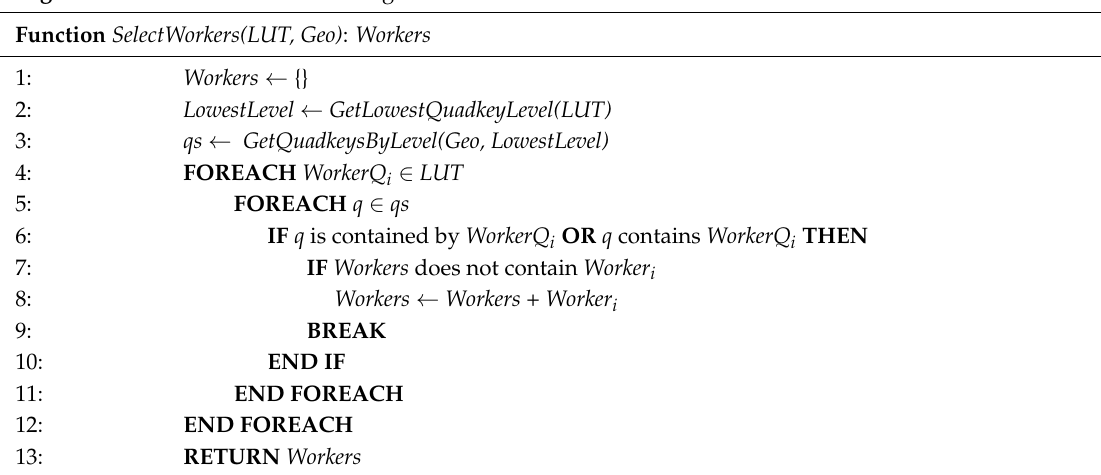
Algorithm 1. The worker selection